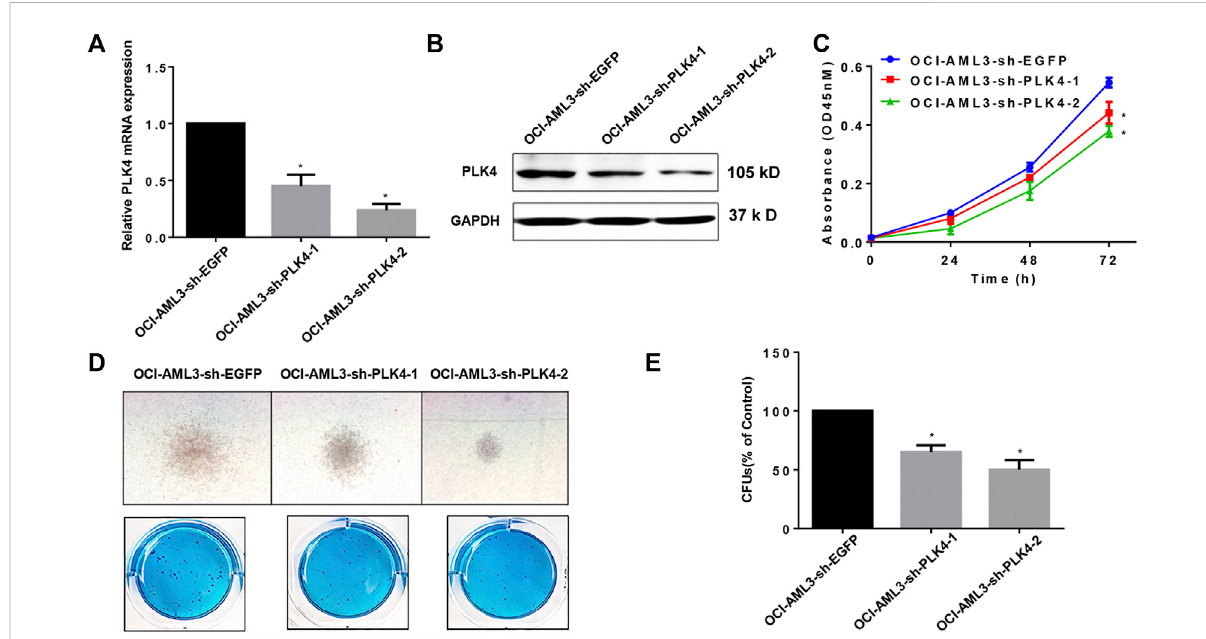
FIGURE 7 KnockdowntheexpressionofPLK4inhibitedtheproliferationandthecolonyformationofOCI-AML3cells. (A) RelativemRNAexpressionlevels of PLK4 in the OCI-AML3 cells after lentivirus medicated transduction, * p < 0.05, compared with OCI-AML3-sh-EGFP group. (B) Expression of PLK4 in transfected OCI-AML3 cells was detected by Western blot. (C) Knockdown the expression of PLK4 inhibited the proliferation of OCI-AML3 cells. * p < 0.05, compared with OCI-AML3-sh-EGFP group. (D) Knockdown the expression of PLK4 inhibited the size and the numbers of the colony formation. Microscopic observation of cell colony generation size (100×) and the number of colony generations was observed after Giemsa staining. (E) Statistical analysis of the number of cell-forming colonies (compared with control, * p <